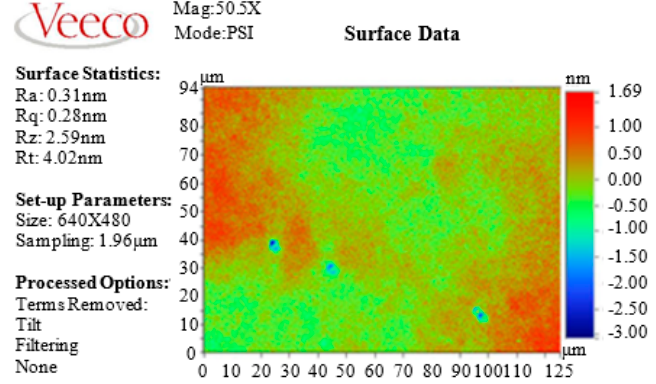
Figure 7. Final surface roughness of silicon wafer processed by DEPP.